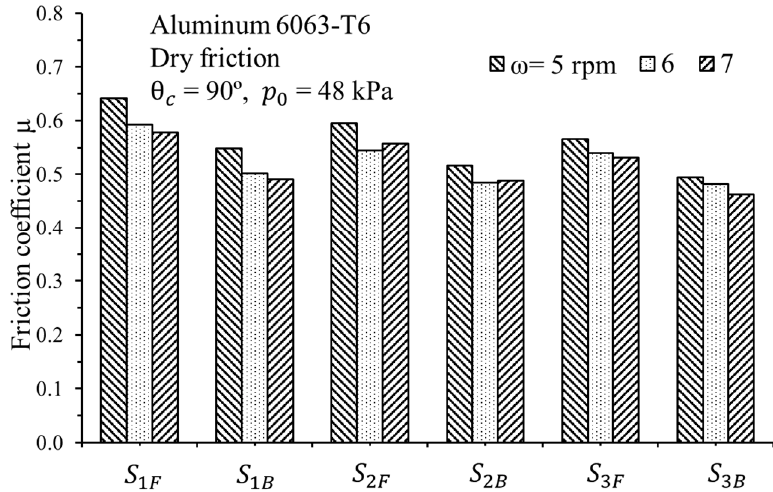
Figure 11. E ff ects of rotation speed on friction coe ffi cient under dry friction conditions for aluminum Figure 11. Effects of rotation speed on friction coefficient under dry friction conditions for aluminum alloy 6063-T6 alloy 6063-T6 strips.